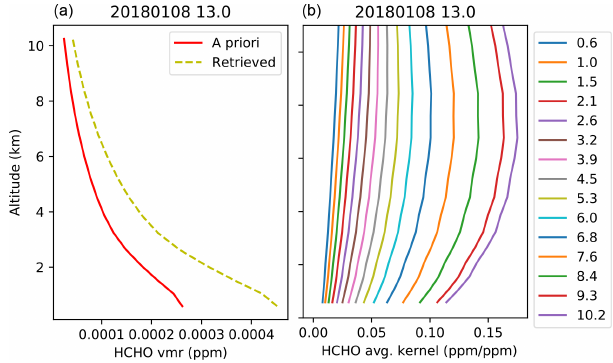
Figure 4. Example FTIR profile retrieval from 13:00LT on 8 Jan- uary 2018 at Lauder. Panel (a) shows a priori and retrieved HCHO profiles in the lowest 10km, and panel (b) shows the corresponding averaging